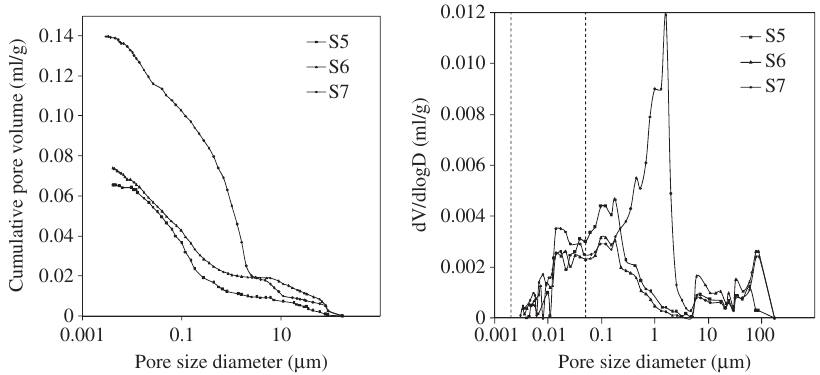
Figure 5 Pore-size distribution of artifically mixed soil samples measured by MIP.